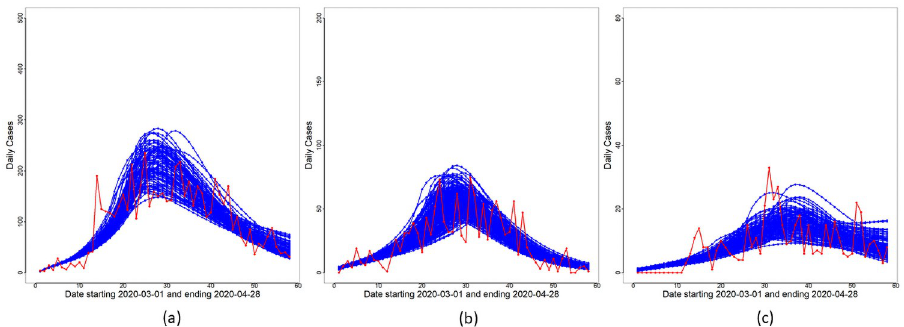
Fig 10. Variation of modelled daily cases. Illustration of the variability of F ( t ) from the posterior: Reported cumulative cases (red line), and overlay plots of F ( t ) for (a) Malaysia, (b) Selangor and (c) Sarawak.